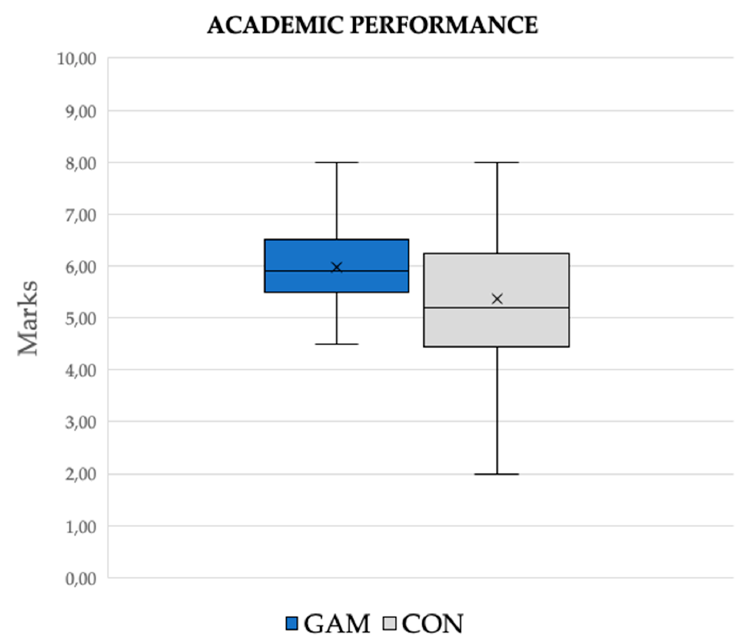
Figure 5. Box diagram of the qualifications obtained in the final exam. Note: GAM = experimental group; CON = control group.